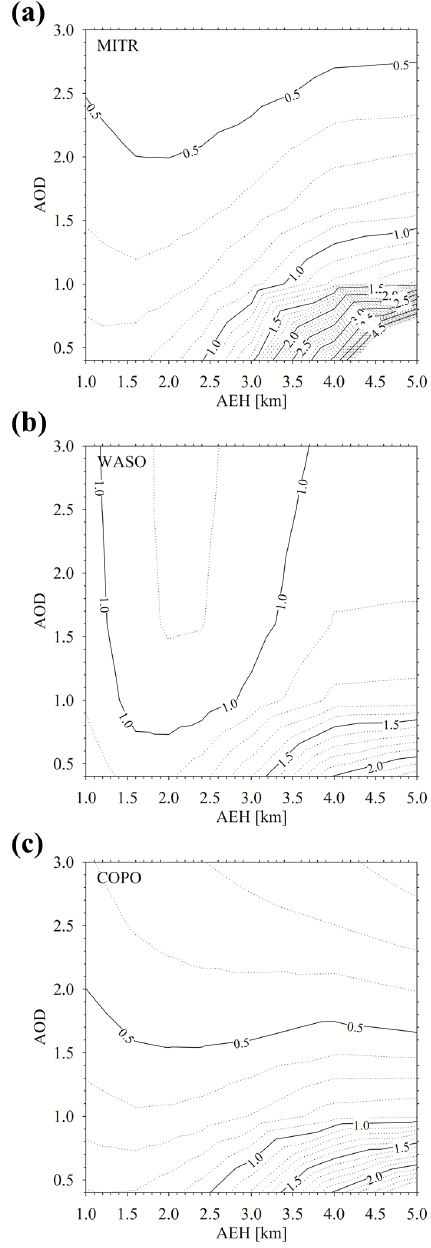
Figure 9. Same as Fig. 7 except for SSA difference of